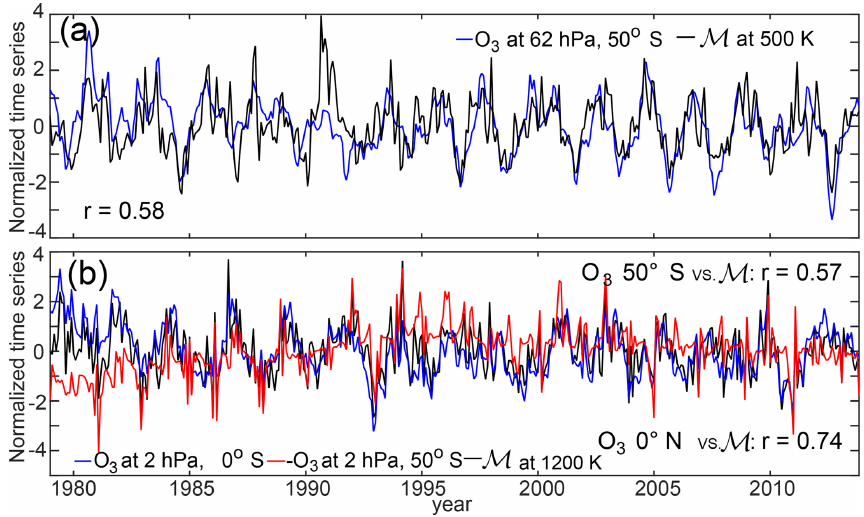
Figure 11. Time series of monthly mean local ozone concentration and the global diabatic circulation from WACCM for the following: (a) 62hPa, 50 ◦ S O 3 in blue and M at 500K in black; (b) 2hPa equatorial O 3 in blue, 2hPa, 50 ◦ S O 3 in red (multiplied by − 1), and M in